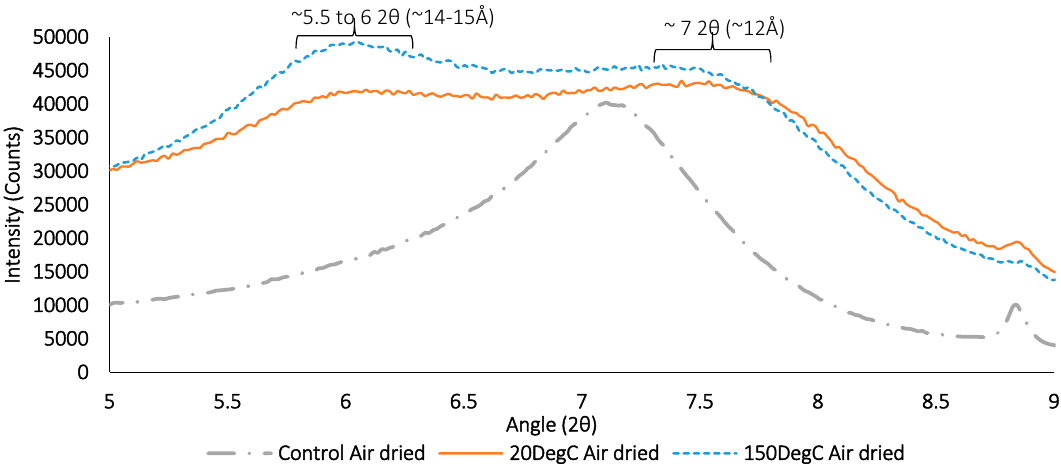
Figure 19. XRD results for air-dried sample containing synthetic groundwater and clay only with no corrosion products. Exposed to ambient temperature (20 °C) and elevated temperature (150 °C) respectively.